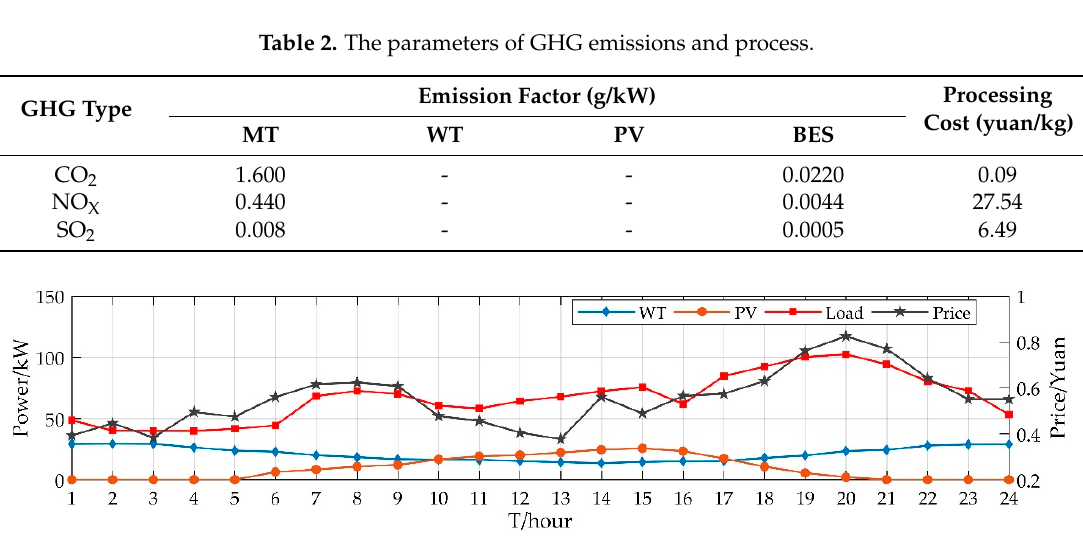
Figure 5. Predicted output of wind power, PV power, load demand and market real-time electricity price in 24 h.